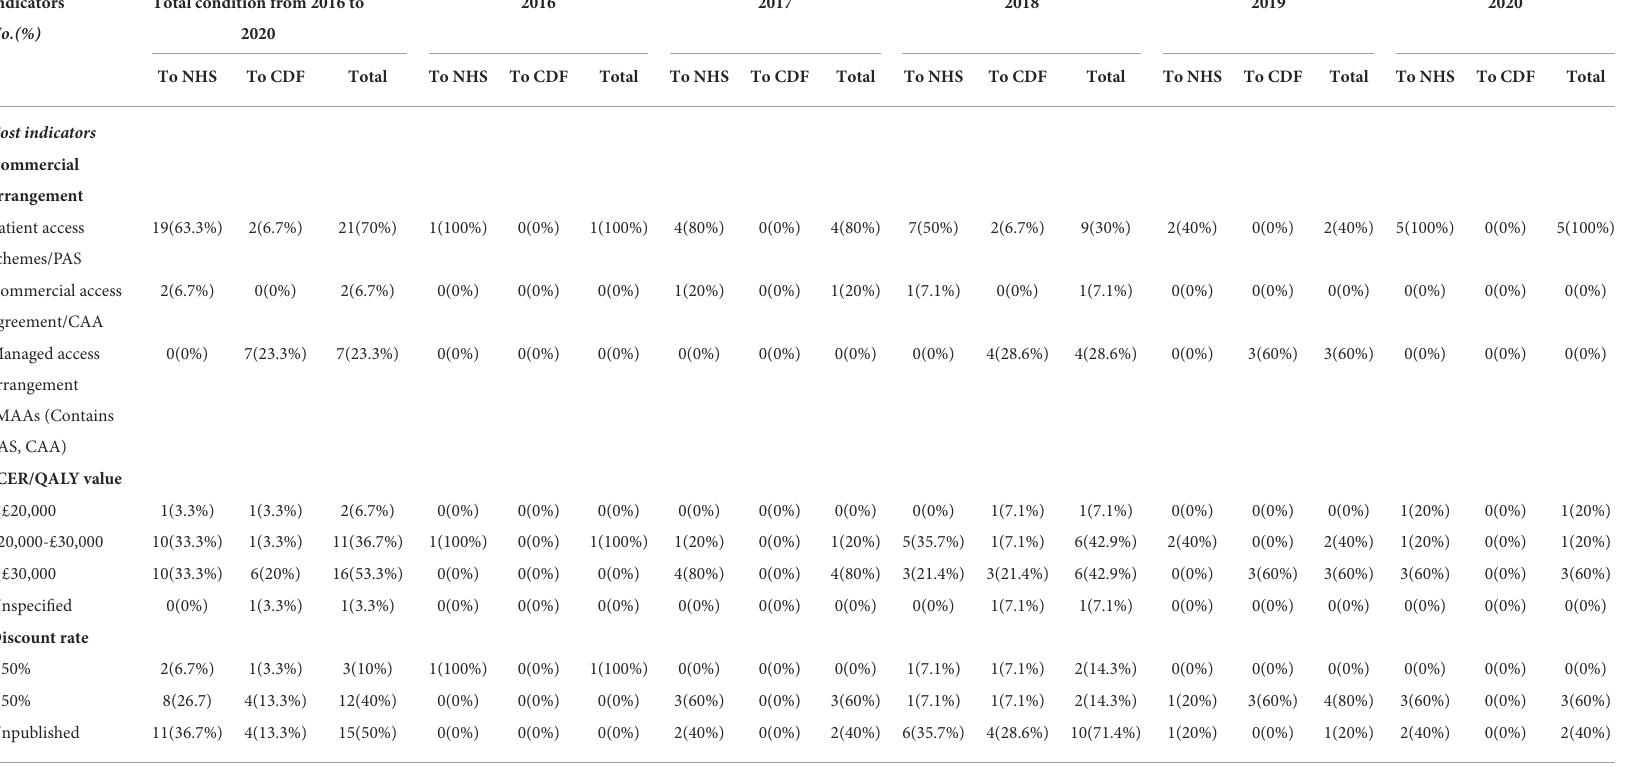
TABLE 3 Details of cost indicators in guidance from 2016 to